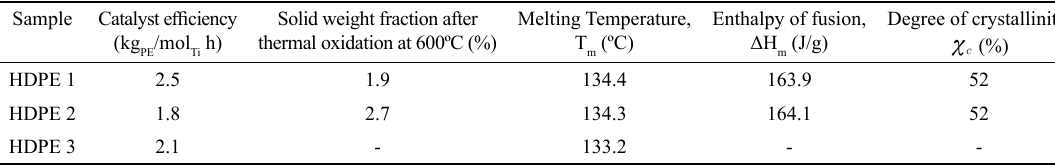
Table 4. Properties of the commercial polymers Sample Melting Temperature, Tm